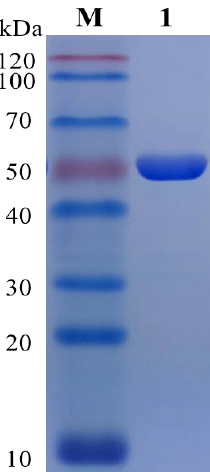
Figure 3. Protein purification. Lane M represents Maker at 120 kDa, and lane 1 represents the target protein after purification by the Ni column. protein after purification by the Ni